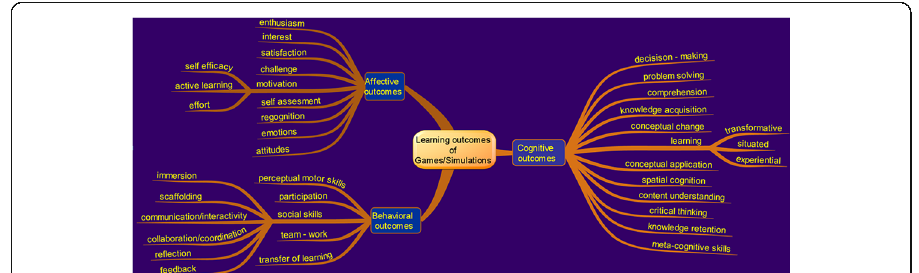
Fig. 8 Learning outcomes of